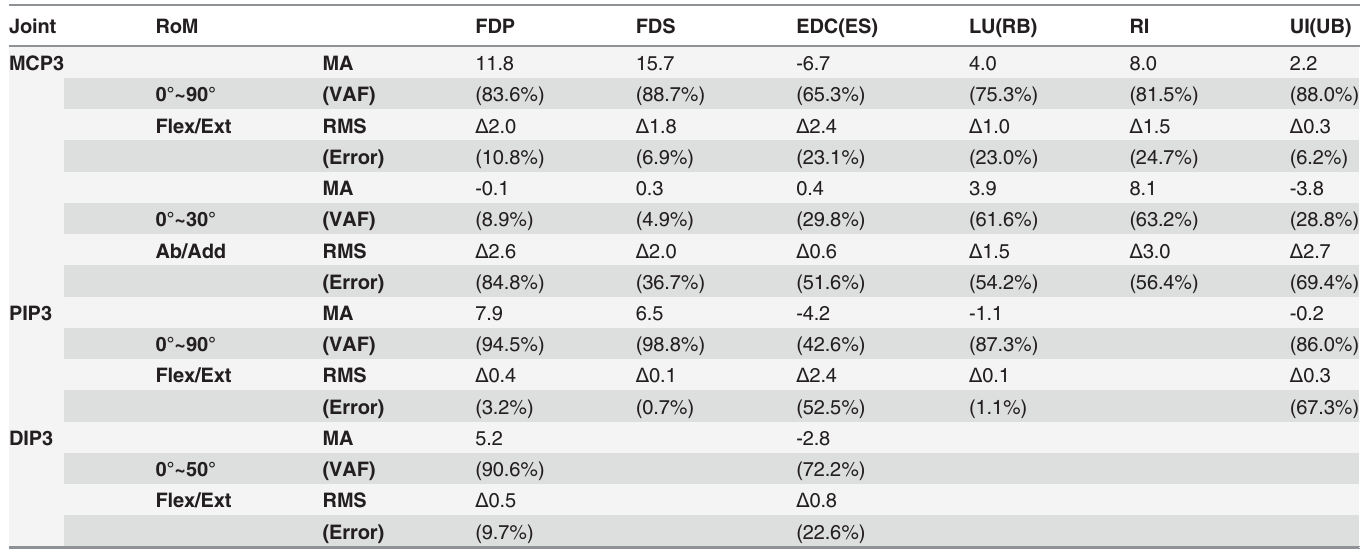
Table 4. Mean moment arms (MA) of the middle